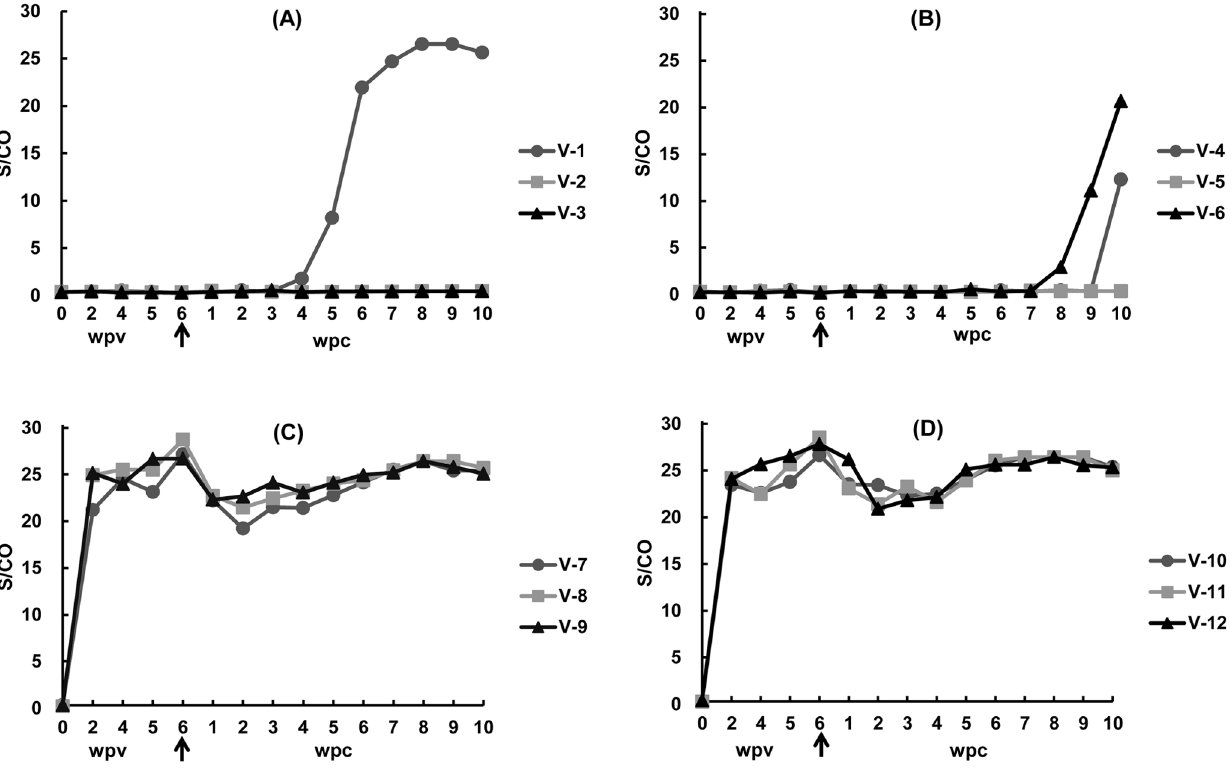
Figure 1. Time course of anti-HEV levels in rabbits vaccinated with HEV 239 vaccine and subsequently challenged with rabbit HEV and swine HEV at 6 weeks post-vaccination (wpv). (A & B) Rabbits inoculated with PBS buffer and challenged at 6 wpv with rabbit HEV and swine HEV of genotype 4, respectively. (C & D) Rabbits vaccinated with HEV 239 vaccine and challenged at 6 wpv with rabbit HEV and swine HEV of genotype 4, respectively. Arrow in the X-axis indicates the time of challenge at 6 wpv. Rabbits were vaccinated on week 0 and two booster doses on week 2 and week 4.